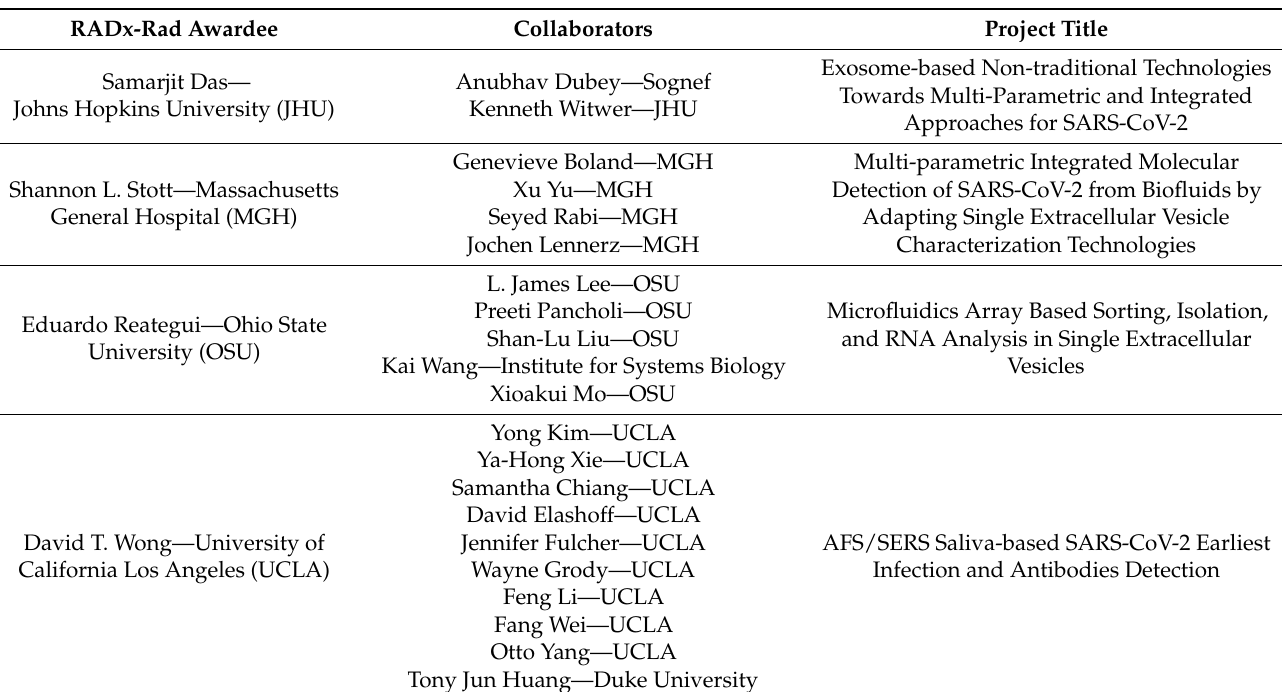
Figure 2. Schematic representing the four projects funded under the RADx-Rad Exosome-based Technologies Towards Multi-Parametric and Integrated Approaches for SARS-CoV-2 FOA. The schematic outlines the awardee institution, the viral separation method, and viral detection method developed under each technology. Table 1. Projects awarded through the RADx-Rad Exosome-based Non-traditional Technologies Towards Multi-Parametric and Integrated Approaches for SARS-CoV-2 program.